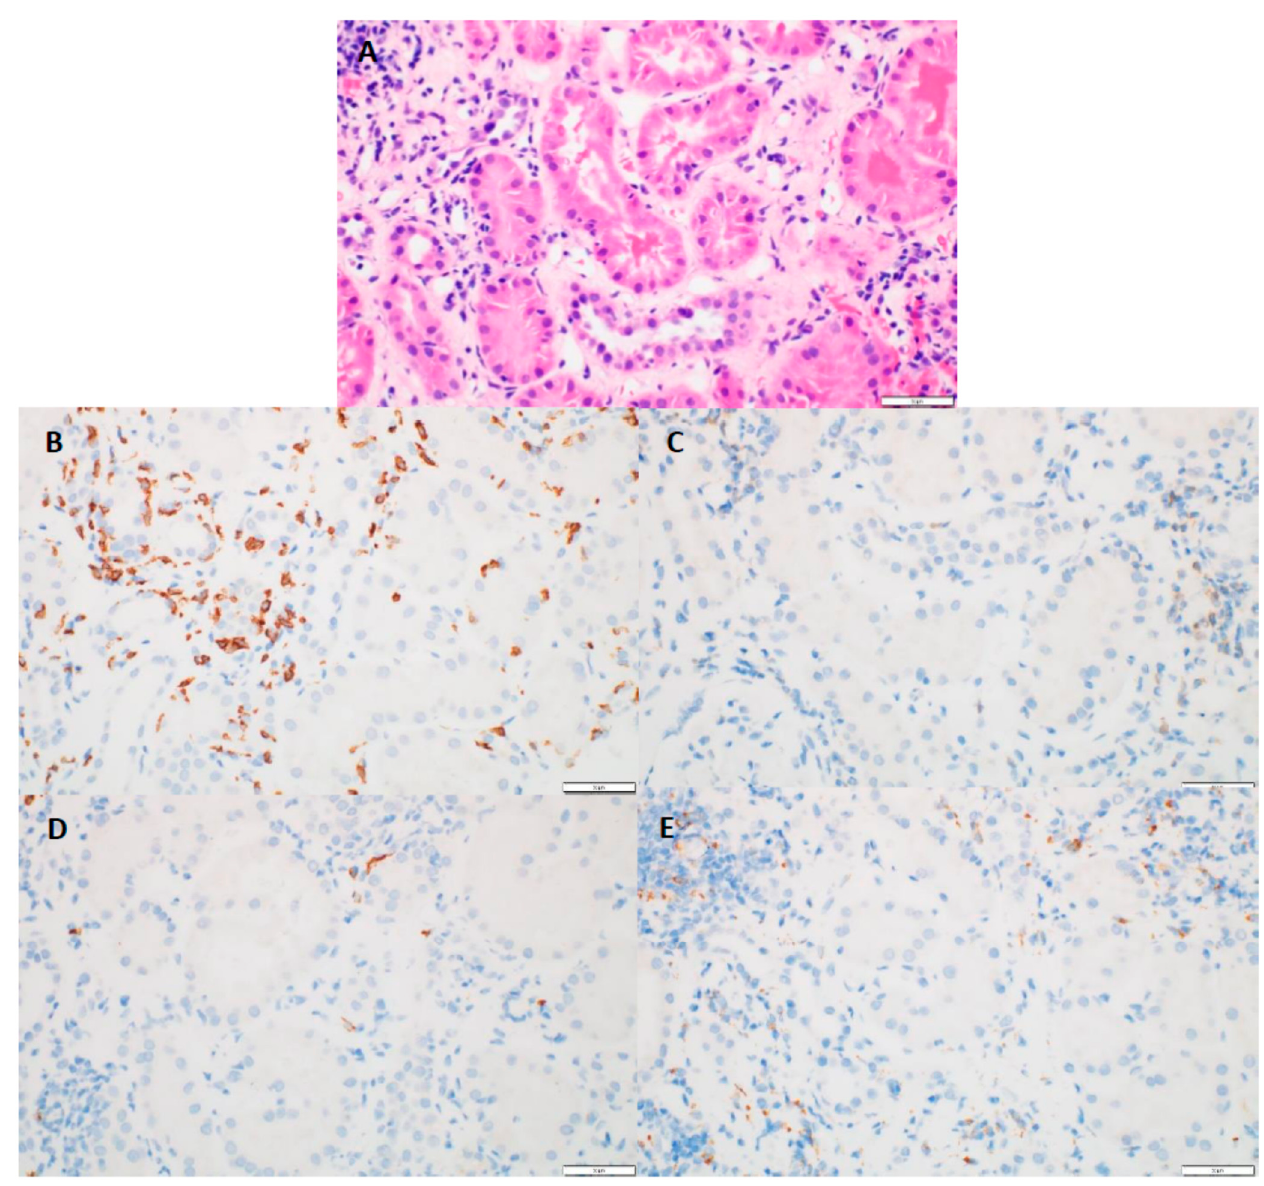
Figure 2. ( A ) (H&E, 40 × )-tubulitis present in non-atrophic tubules; ( B ) (CD8, 40 × )-numerous positive cells present with the areas of tubulitis; ( C ) (CD4, 40 × )-absence of positive staining cells within tubulitis; ( D ) (C20, 40 × )-absence of positive staining cells within tubulitis; ( E ) (CD68, 40 × )-absence of positive staining cells within tubulitis.